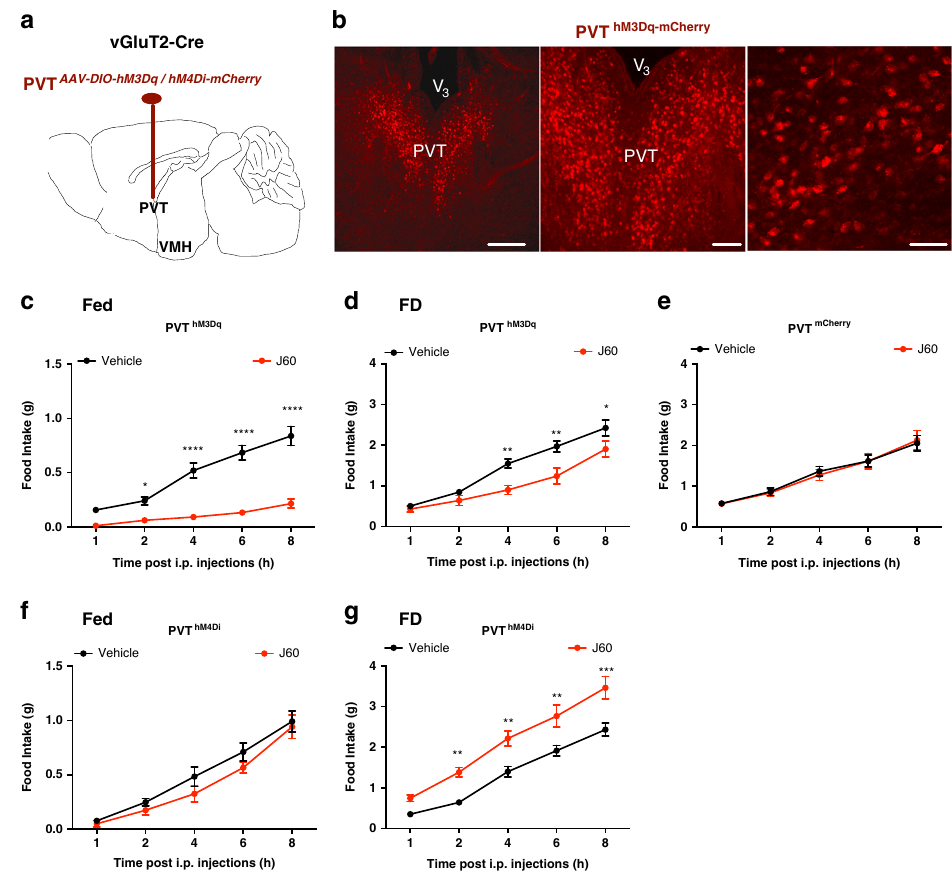
Fig. 5 Activation of PVT neurons reduces feeding. a Schematic depiction of targeting vectors carrying Cre-dependent DREADD-hM3Dq, hM4Di, or mCherry in PVT of vGluT2-Cre mice. b Representative confocal images of DREADD expressions in PVT neurons. c – g Feeding behavioral experiments were performed in fed and 24 h food-deprived mice respectively: activation of PVT neurons with J60 i.p. injections reduced food intake in both c fed ( n = 9; 2h vehicle vs J60 , p = 0.0427; 4h vehicle vs J60 , p < 0.0001; 6h vehicle vs J60 , p < 0.0001; 8h vehicle vs J60 , p < 0.0001) and d refeeding in food deprived (FD) ( n = 8; 4h vehicle vs J60 , p = 0.0062; 6h vehicle vs J60 , p = 0.0015; 8h vehicle vs J60 , p = 0.0433) hM3Dq-transduced mice but not in e mCherry-transduced animals ( n = 8); DREADD inhibition of PVT neurons with J60 i.p. injections did not affect food intake in f fed mice ( n = 7) but increased refeeding in g deprived mice ( n = 10; 2h vehicle vs J60 , p = 0.0095; 4h vehicle vs J60 , p = 0.0034; 6h vehicle vs J60 , p = 0.0021; 8h vehicle vs J60 , p = 0.0001). Two-way ANOVA with Sidak post hoc tests; data represent mean ± s.e.m.; * p < 0.05; ** p < 0.01; *** p < 0.001; **** p < 0.0001. Scale bars for b 200 μ m (left), 100 μ m (middle), and 50 μ m (right). PVT paraventricular thalamus, V 3 third ventricle, VMH ventromedial